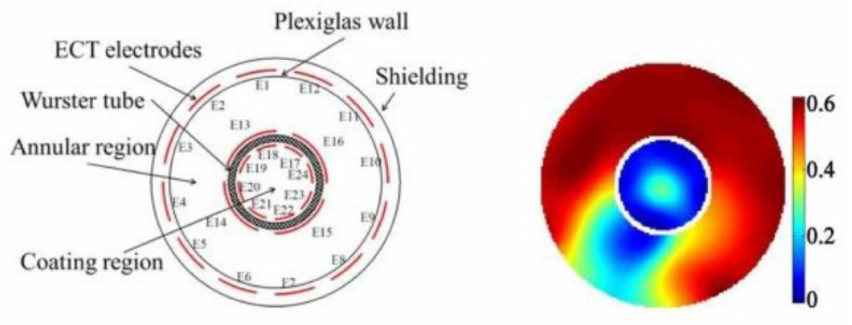
Figure 26. A cross-section model of ECT [31].